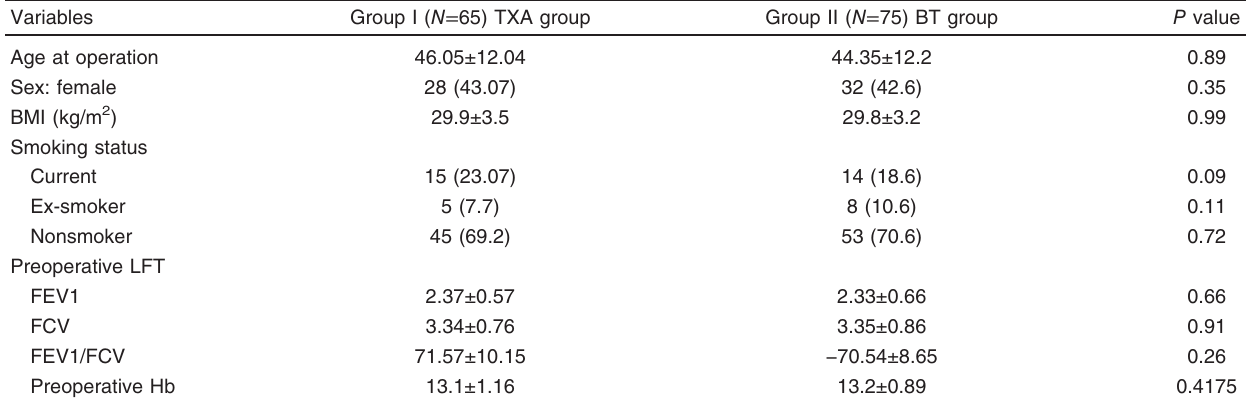
Table 1 Clinical characteristics of patients in both groups (total number = 140 patients: group I = 65 and group II = 75) Variables